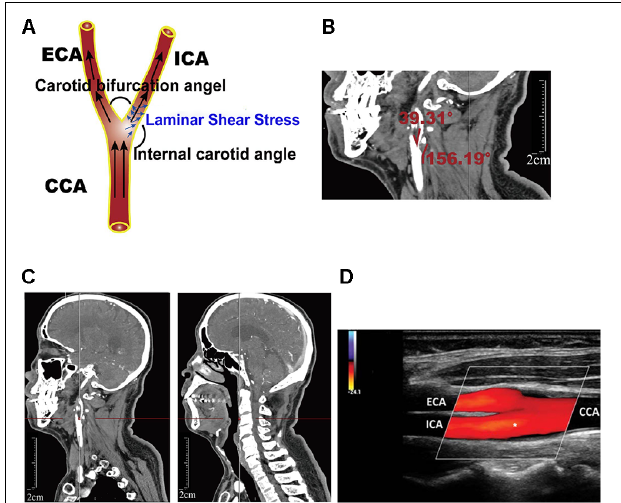
FIGURE 1 | Definition of geometric parameters. (A) Schematic representation of geometric parameters, including carotid bifurcation angle, internal carotid angle, and related laminar shear stress, angle of the internal carotid angle with respect to the common carotid artery, hereafter termed “internal carotid angle.” (B) Computed tomography angiography (CTA) image illustrating the method of measuring carotid bifurcation angle and internal carotid angle (red line). (C) CTA image illustrating measurement of carotid bifurcation angle height relative to the cervical spine. (D) Ultrasonography